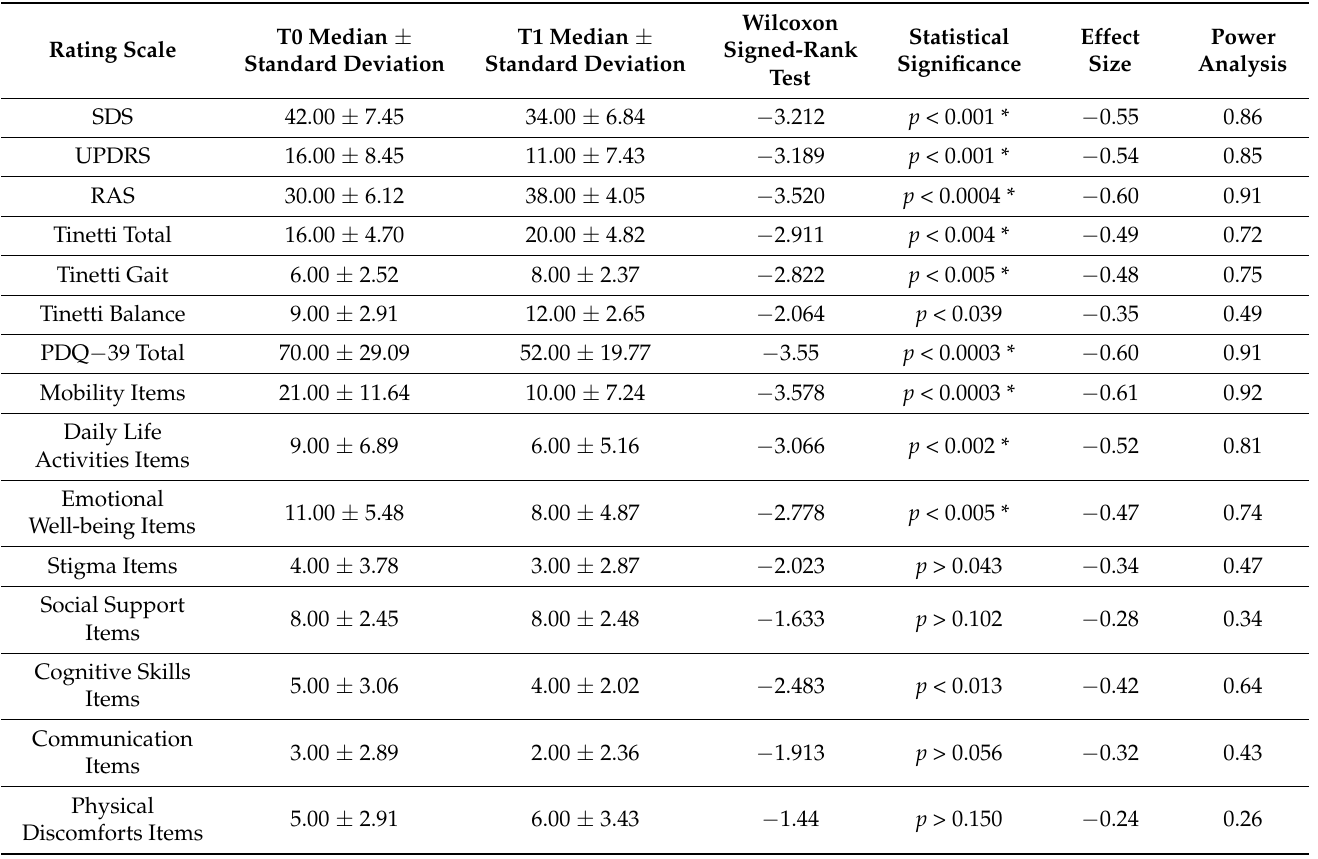
Table 2. Median at the beginning and after 10 sessions of equine therapy and calculation of the value of p of the administered assessment scales (Self-rating Depression Scale, Unified Parkinson’s Scale